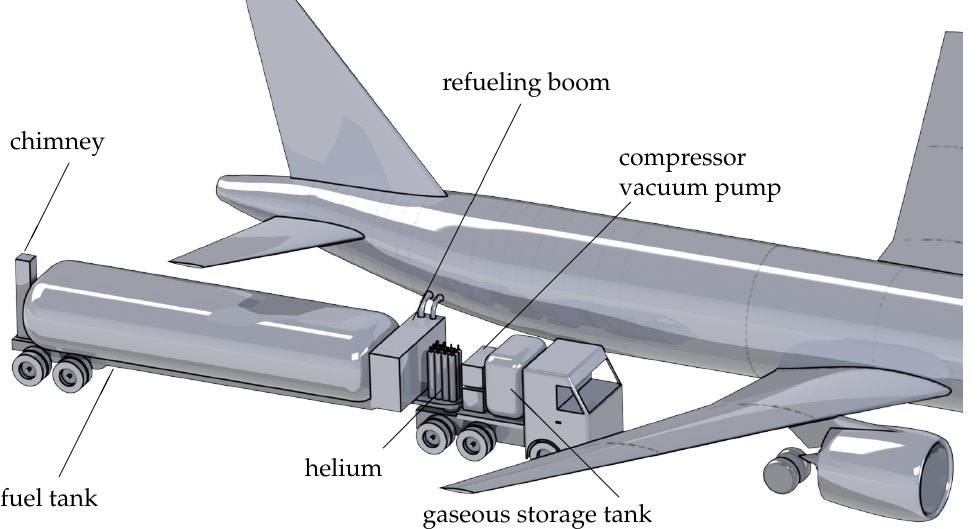
Figure 2. Refueling truck independent of the pipeline system; capacity of 70m 3 LH2; truck